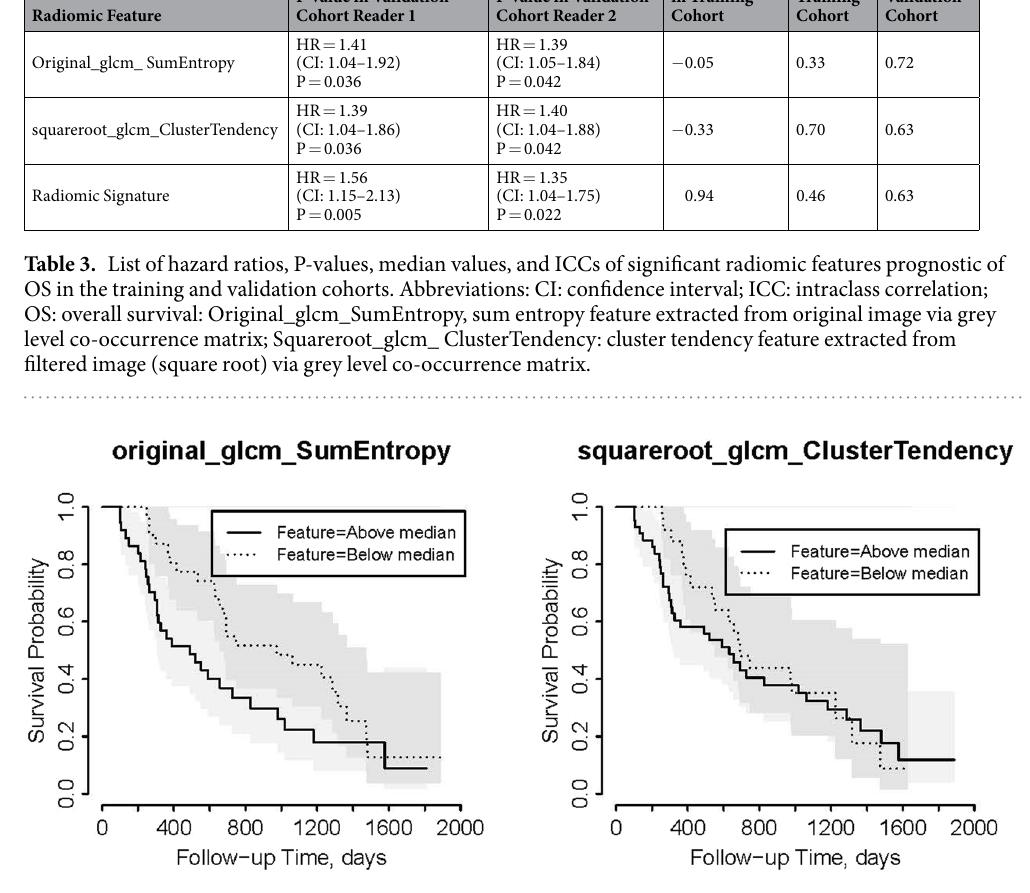
Figure 1. Kaplan-Meier plots for OS for the validation cohort with Reader 1 contours dichotomized based on the median values of significant features in the training